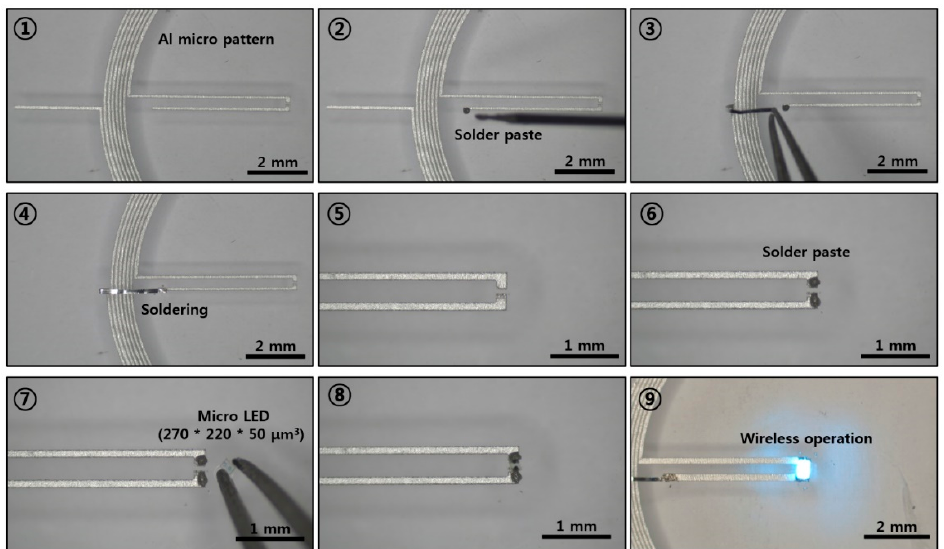
Figure A2. Stereomicroscope images of the soldering procedure for chip integration. Solder paste is placed on the parts that will be connected with the antenna and LED chip using a fine needle. The micro-LED was integrated with a soldering gun and micro-tip.